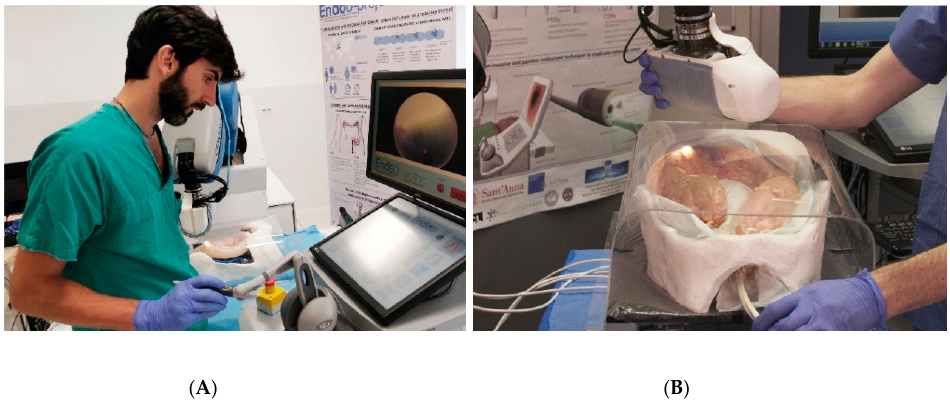
Figure 3. Control modalities of the Endoo platform: ( A ) teleoperated (master–slave operation via the haptic interface); ( B ) interactive (hand-guidance, operated by holding and applying pressure on the external magnet).